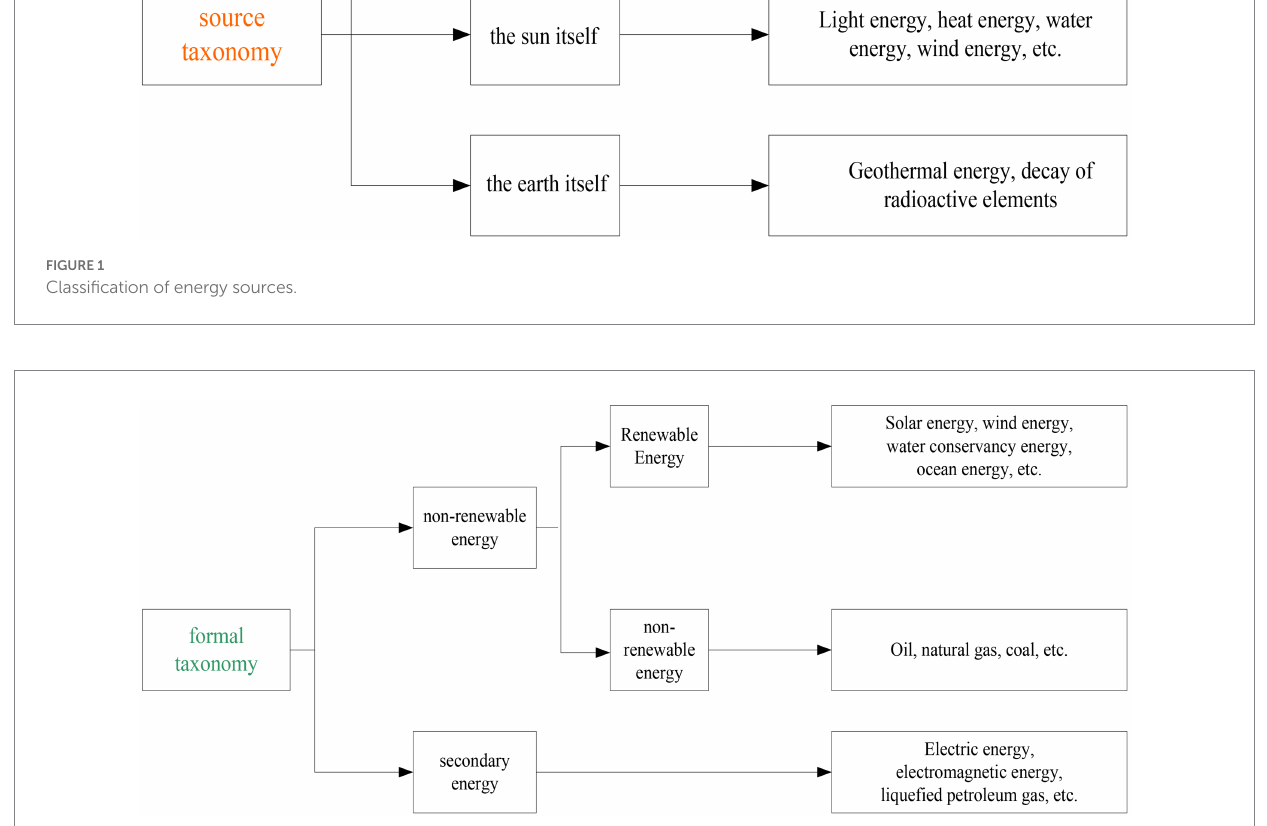
FIGURE 2 Classification of energy